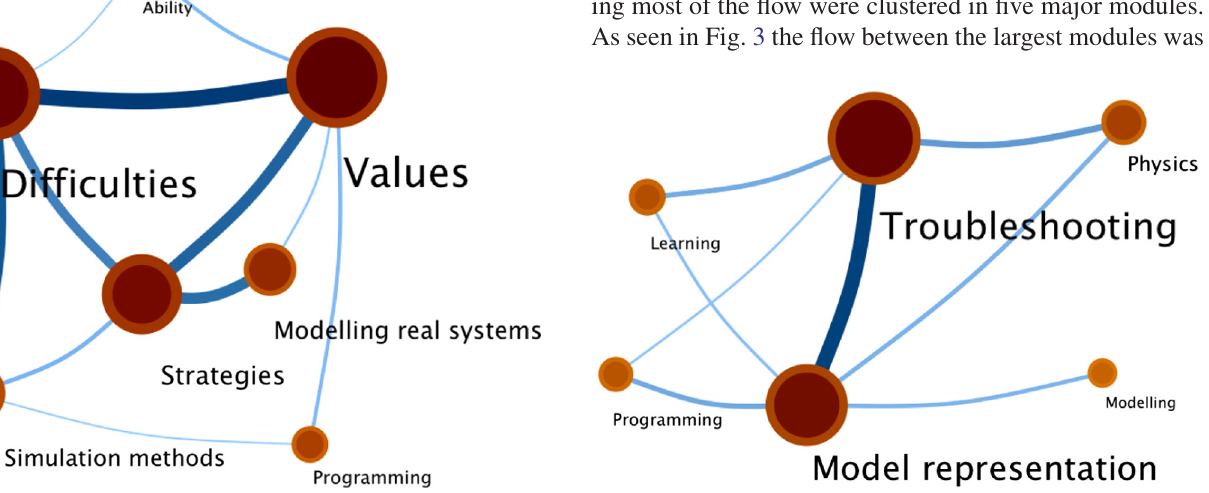
FIG. 3 (color online). Simplified epistemic networks before the problem-solving task. The size of each module corresponds to the importance of the module in the network, i.e., how much focus students put on associating between epistemic elements within that module, and the width of each link represents the information flow between modules. This network captures 97% of the node flow and 82% of the link flow.